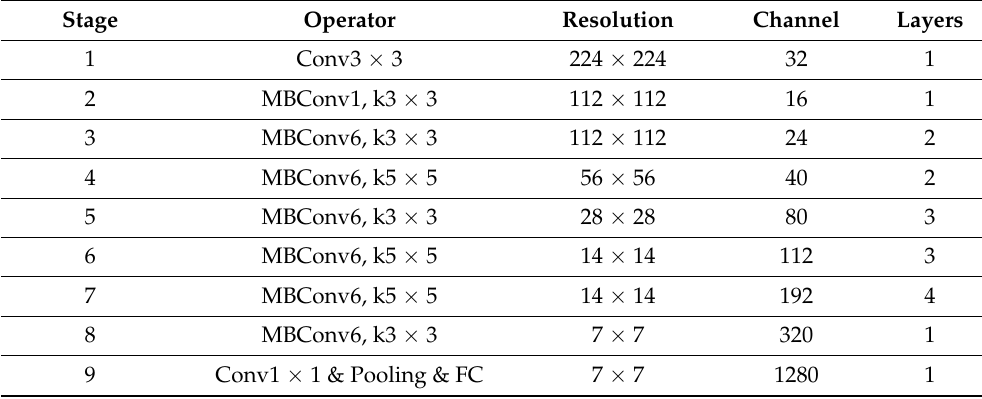
Table 2. Architecture of EfficientNetB0